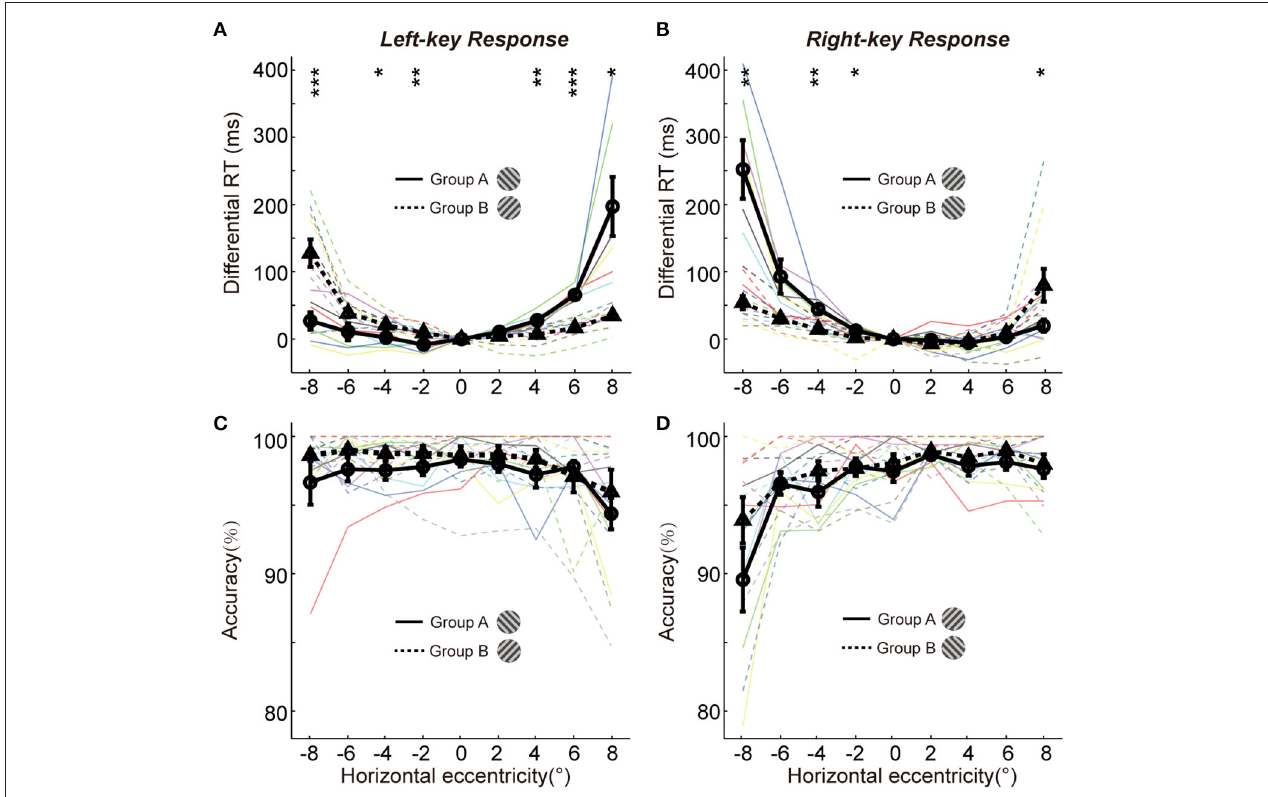
FIGURE 2 | The differential RTs and accuracies of two groups in orientation discrimination task. (A,B) The differential RTs are plotted against the grating horizontal eccentricity with left-key (A) and right-key (B) response. (C,D) The accuracies are plotted against the grating horizontal eccentricity with left-key (C) and right-key (D) response. The solid black curve (through circles) and dashed black curve (through triangles) represent mean differential RTs/accuracies of group A and B, respectively. The black vertical bars denote ± SEM. The thin solid and dash color lines represent the differential RTs/accuracies of individual subject in group A and B, respectively. Asterisk denotes the results of post-hoc t -test between two groups: * P < 0.05, ** P < 0.01, *** P <